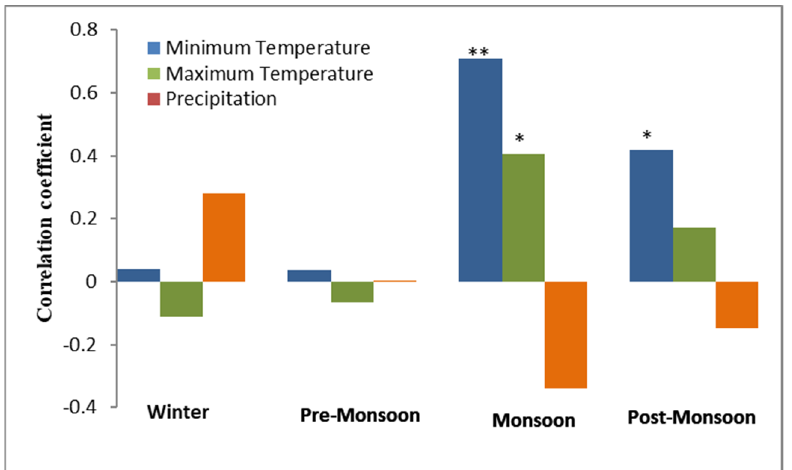
Figure 9. Correlation coefficients of recruitment with seasonal temperature and precipitation (1980–